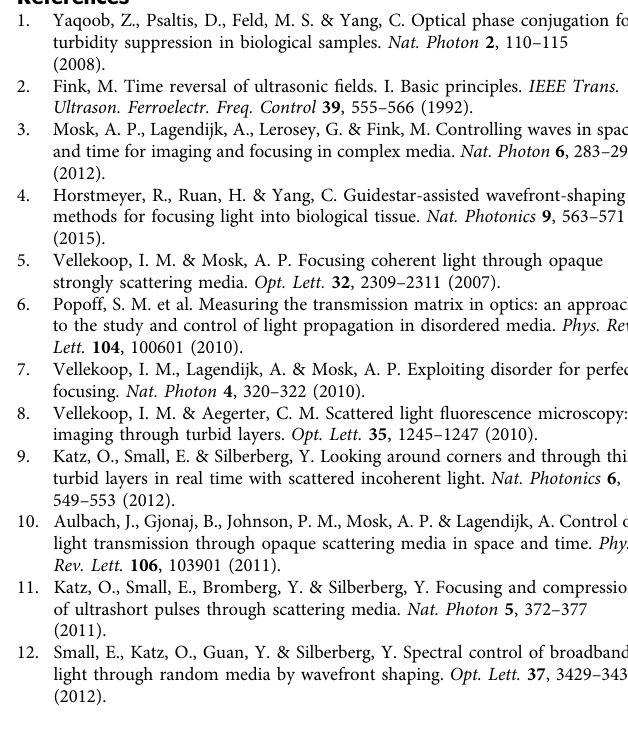
Supplementary Figure 2. To minimize the fraction of the unshaped light from the SLM limited fi ll-factor, a blazed grating phase pattern was displayed on the SLM and the zero diffraction order was blocked. The displayed phase patterns on the SLM were composed of macro pixels of 20×20 physical pixels, displaying the